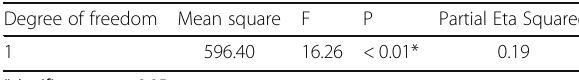
Table 4 Repeated measure ANOVA comparing the mean visual analogue scale scores between experimental and